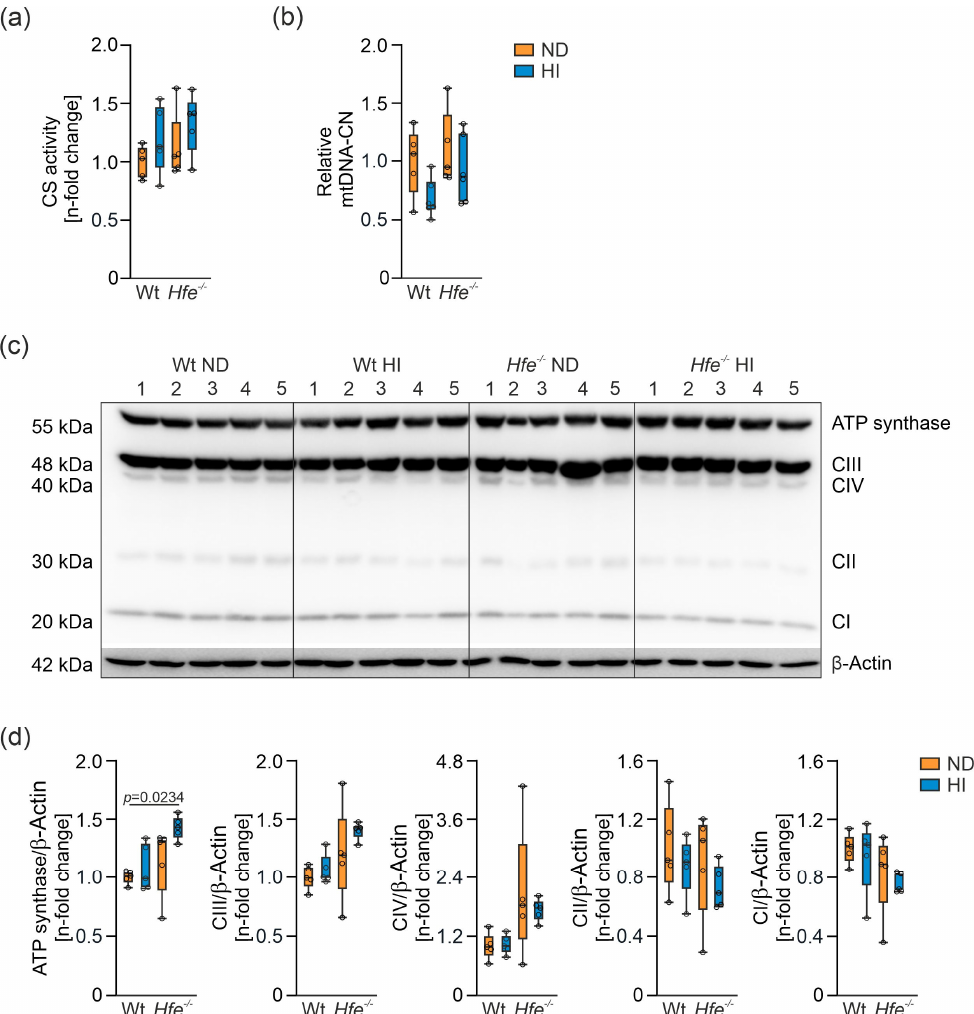
Figure 7. Effects of dietary and genetic iron overload on liver mitochondrial density and protein expression of mitochondrial electron transfer complexes I to IV (CI to CIV) and ATP synthase. ( a ) Citrate synthase (CS) activity, ( b ) relative mitochondrial DNA copy number (mtDNA-CN), ( c ) Western blot of C I to CIV and ATP synthase and ( d ) densitometric quantification of CI to CIV and ATP synthase relative to the house keeping protein β -Actin which served as control. Values are depicted as n-fold change of Wt ND. All results were obtained from snap-frozen samples. n = 5–6 mice per group. Kruskal–Wallis test: ( a ) p = 0.2933; two-way ANOVA: ( b ) diet, F (1,18) = 4.479, p = 0.0485; genotype, F (1,18) = 2.303, p = 0.1465; diet X genotype, F (1,18) = 0.4127, p = 0.5287; ( d ) Kruskal–Wallis test: ATP synthase— p = 0.0183; two-way ANOVA: CIII—diet, F (1,16) = 1.788, p = 0.1998; genotype, F (1,16) = 7.107, p = 0.0169; diet X genotype, F (1,16) = 0.4672, p = 0.5040; CIV—diet, F (1,16) = 0.2165, p = 0.6480; genotype, F (1,16) = 7.756, p = 0.0132; diet X genotype, F (1,16) = 0.3278, p = 0.5749; CII—diet, F (1,16) = 1.472, p = 0.2427; genotype, F (1,16) = 0.9855, p = 0.3356; diet X genotype, F (1,16) = 0.04946, p = 0.8268; CI—diet, F (1,16) = 0.6000, p = 0.4499; genotype, F (1,16) = 4.016, p = 0.0623; diet X genotype, F (1,16) = 0.01808, p = 0.8947. Values are shown as median ± interquartile range. The exact p -values are indicated in the